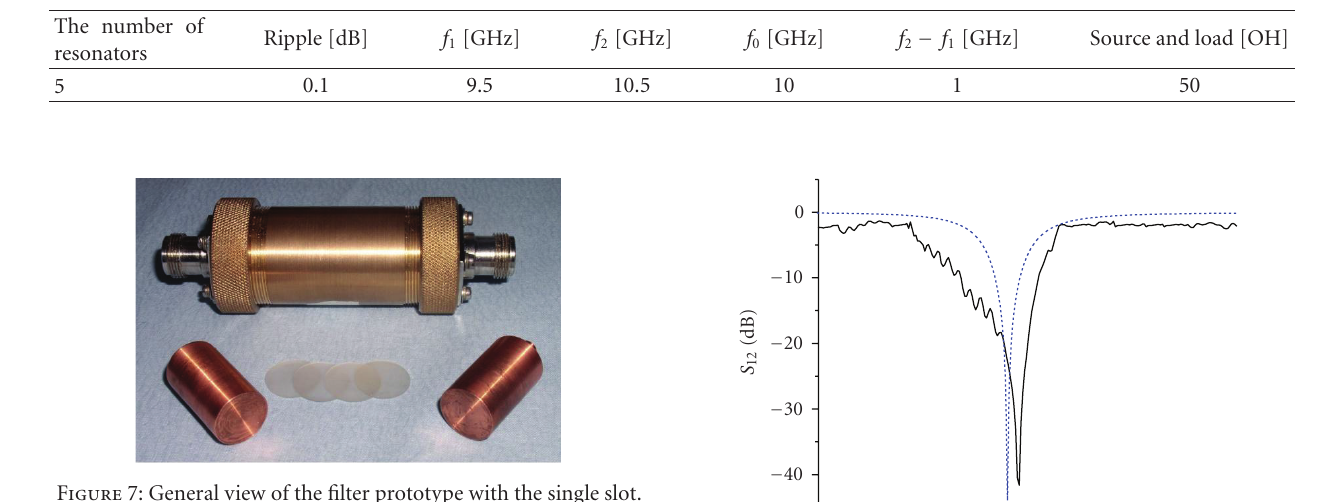
Table 2: The parameters of the Chebyshev filter.